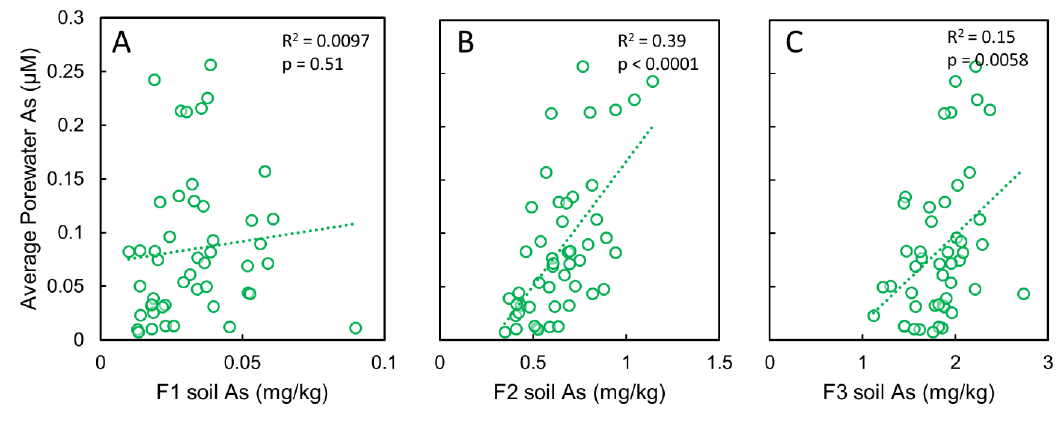
Figure 9. Relations between porewater As and soil-extractable As in the ( A ) F1, ( B ) F2, and ( C ) F3 fractions.